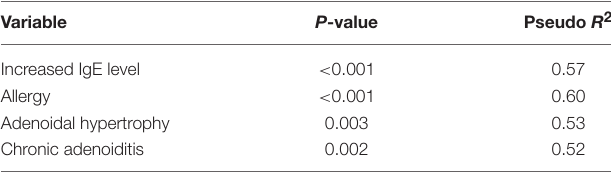
TABLE 2 | Results of multivariate logistic regression